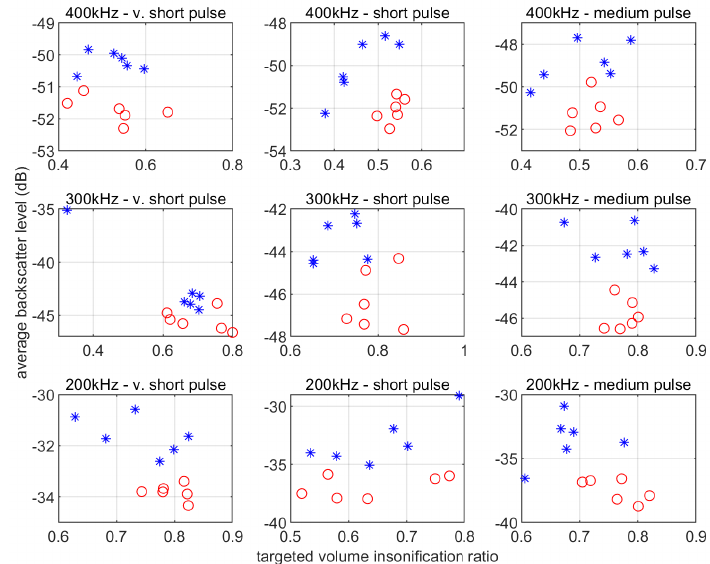
Figure 12. Average of the filtered backscatter level recorded within the target volume as a function of the ratio of the targeted volume that was insonified. Each of the nine plots displays the data for one combination of the sonar settings: ( top left ) 400 kHz and 25 μs pulse, ( top ) 400 kHz and 50 μs pulse, ( top right ) 400 kHz and 100 μs pulse, ( left ) 300 kHz and 25 μs pulse, ( middle ) 300 kHz and 50 μs pulse, ( right ) 300 kHz and 100 μs pulse, ( bottom left ) 200 kHz and 25 μs pulse, ( bottom ) 200 kHz and 50 μs pulse, ( bottom right ) 200 kHz and 100 μs pulse . Colours and symbols differ for the dense forest patch (blue stars) and thin forest patch (red circles).